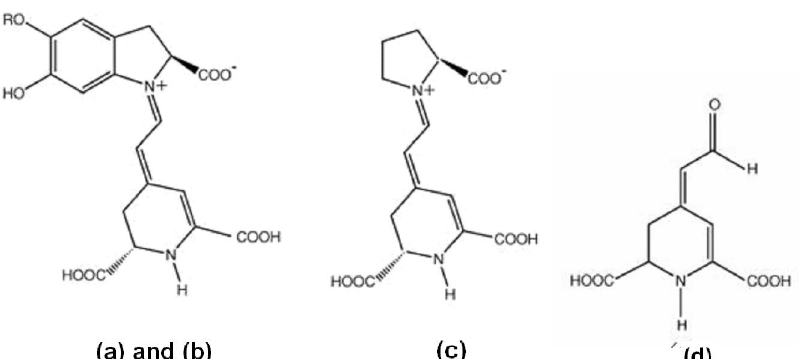
Figure 1. Schematic structures of betacyanin ( a ) Betanin R = β- D -glucose; ( b ) Betanidin R = H; ( c ) Indicaxanthin; ( d ) Betalamic